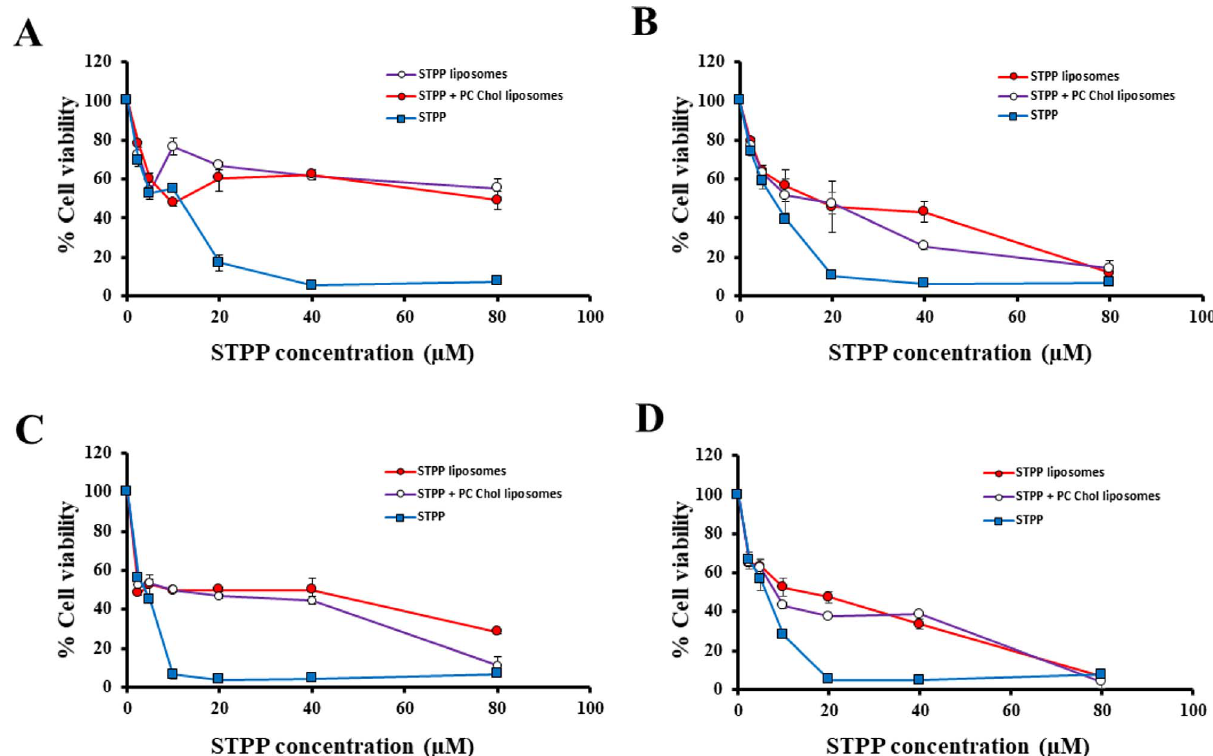
Figure 2. Quantitative determination of STPP toxicity in human ovarian carcinoma cells. Percent cell viability in A, C : A2780 cells and B, D : Ovcar-3 cells, treated with STPP liposomes, STPP in DMSO and STPP in DMSO mixed with PC:Cholesterol liposomes for A, B : 5 h and C, D : 12 h at indicated concentrations of STPP. Values represent mean ± standard deviation from three independent